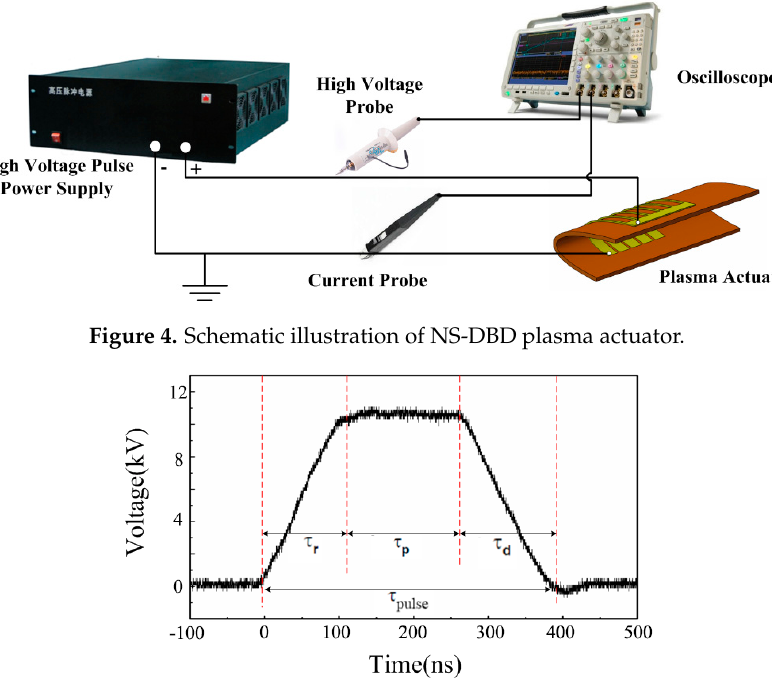
Figure 5. Sketch of a positive nanosecond voltage pulse with rise time τ r , plateau time τ p and decay time τ d .